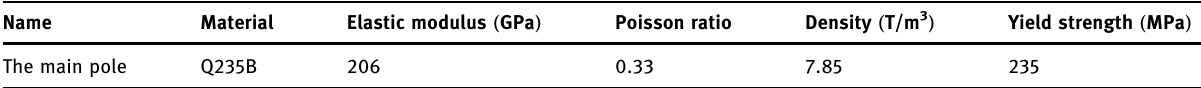
Table 1: Parameters of the main rod